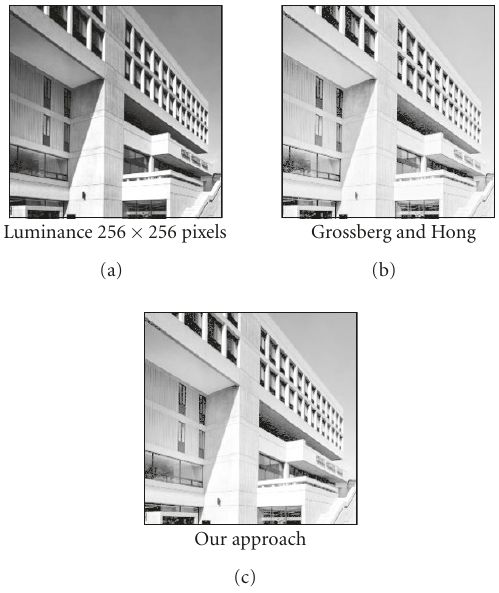
Figure 8: MIT image : (a) shows the input image, with luminance values originally varying from 0 to 255. The input image was nor- malized such that the maximum intensity value was 1, and the min- imum 0. Subsequently, all zero luminance values were substituted by (cid:2) = (1 / 255) / 2. (b) shows the result obtained with the method described in [19, 20] (500 iterations). (c) was obtained with our approach (150 iterations; convergence occurred within simulation time). Both (b) and (c) show the cone’s membrane